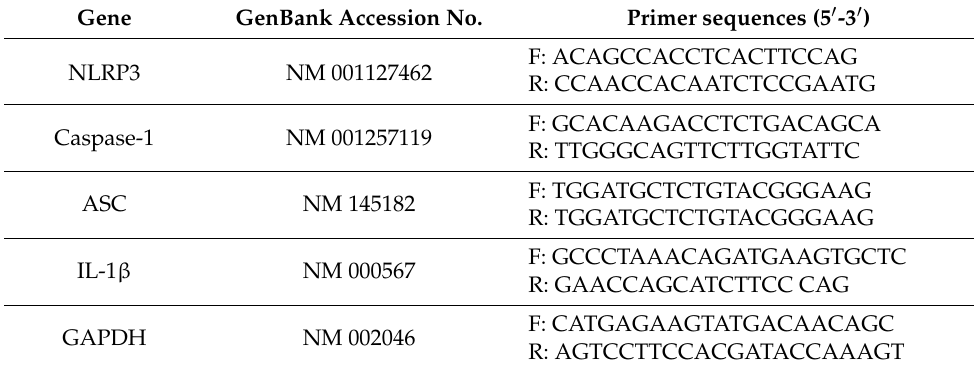
Table 1. Primer sequences for real-time quantitative PCR.